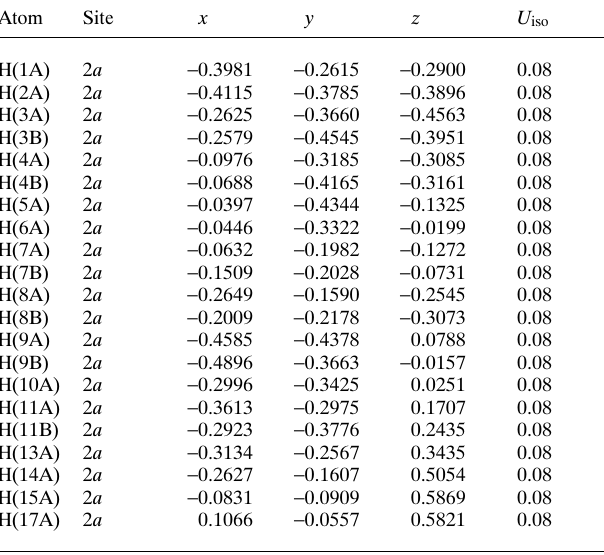
Table 2. Atomic coordinates and displacement parameters (in Å 2 )